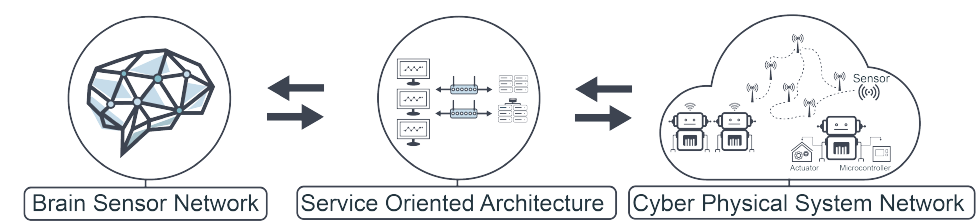
Figure 1. Basic human central nervous system monitoring process with a